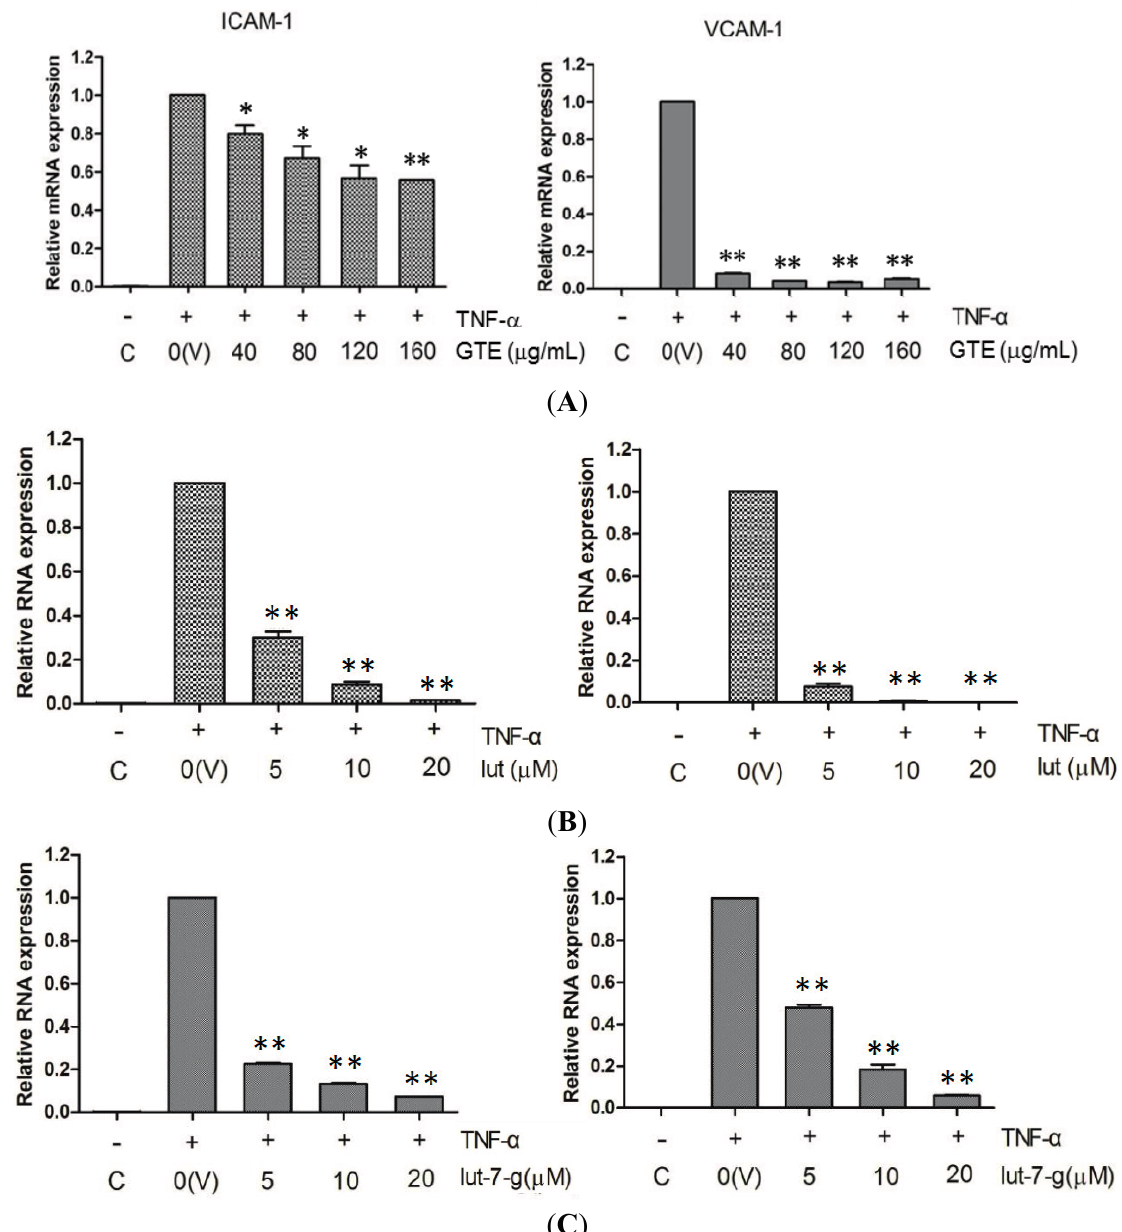
Figure 4. Inhibition of TNF- α -induced mRNA expression of adhesion molecules by: ( A ) GTE; ( B ) lut; and ( C ) lut-7-g. TNF- α -activated HUVECs were pretreated with vehicle only (V), GTE (40, 80, 120, 160 μ g/mL), lut (5, 10, 20 μ M), lut-7-g (5, 10, 20 μ M), and OA (5, 10, 20 μ M) for 2 h. Real-time RT-PCR analysis was performed to analyze the expression level of mRNA of ICAM-1 and VCAM-1. A significant difference from the vehicle was indicated as, * p < 0.05, or ** p < 0.01 (Student’s t